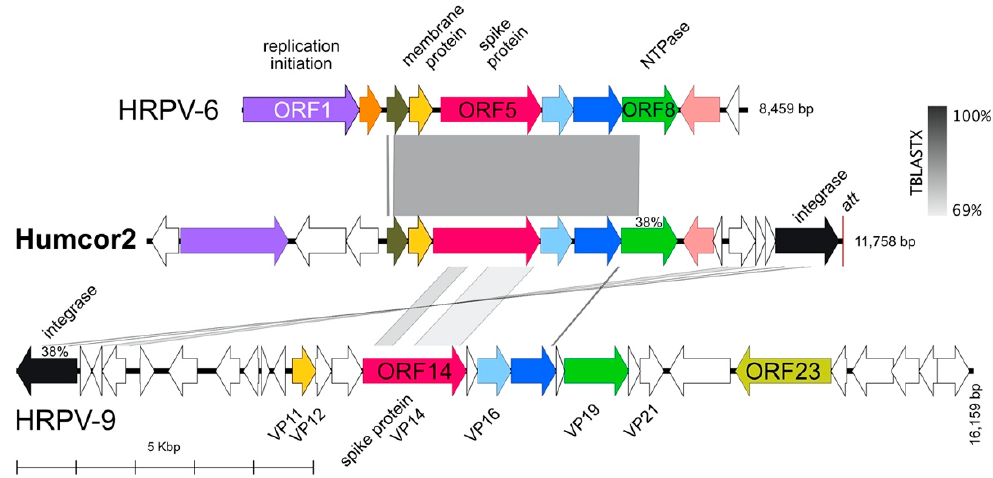
Figure 6. Provirus Humcor2 (MW344764) compared to the alphapleolipovirus HRPV-6 (JN882266) and the betapleolipovirus HRPV-9 (KY965934). Genes coding for corresponding proteins are coloured the same. Similarity, tBLASTx is indicated by greyscale shading, with the greyscale key shown at the top right. Length scale (kb) is given at the lower left.